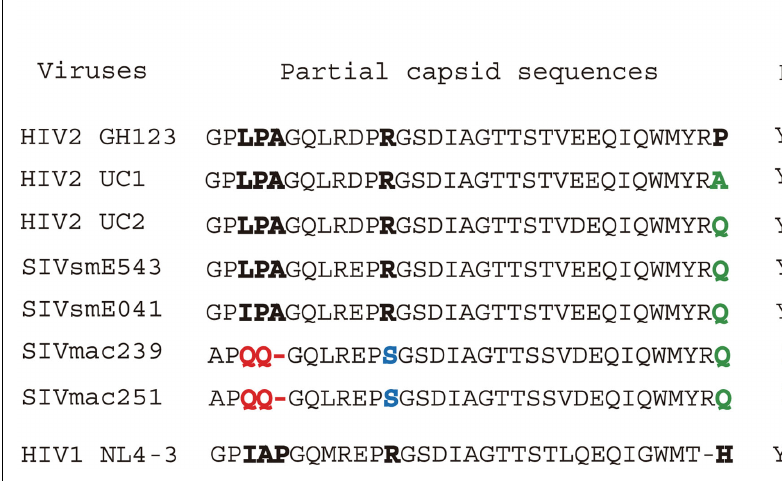
important to escape fromTFP alleles of Rh-TRIM5 α , Rh TFP (Kirmaier et al., 2010), is shown in blue.The glutamine and alanine residues at position 120 of GH123 or analogous positions of other HIV-2 strains, which is critical for resistance against Q alleles of Rh-TRIM5 α , Rh Q (Kirmaier et al., 2010) and CM TRM5 α (Song et al., 2007; Kono et al., 2008), are shown in green. CM CypA(NE) and CM CypA(DK) denote the minor and major alleles of CMTRIMCyp,